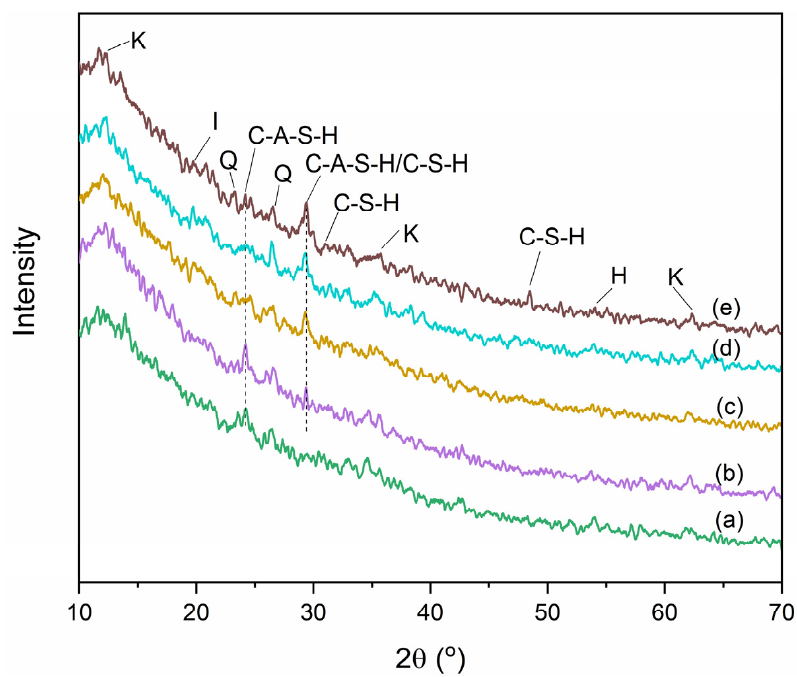
Figure 4. XRD diffractograms of geopolymer materials prepared using 8 M NaOH activator and Ca(OH) 2 content of 15 g (a), 30 g (b), 45 g (c), 60 g (d), 75 g (e) at 28 days of curing time (Q: quartz; K: kaolinite; I: illite; H: hematite; C-A-S-H: calcium aluminosilicate hydrate; C-S-H: calcium silicate hydrate).